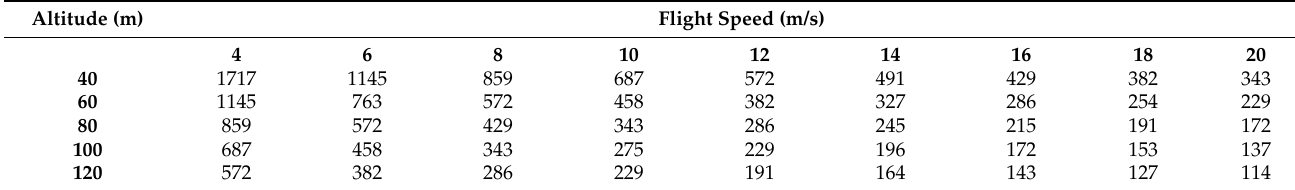
Figure 2. Theoretical point density, based on altitude and flight speed. Table 1. Theoretical point density in points per square meter (points/m 2 ).